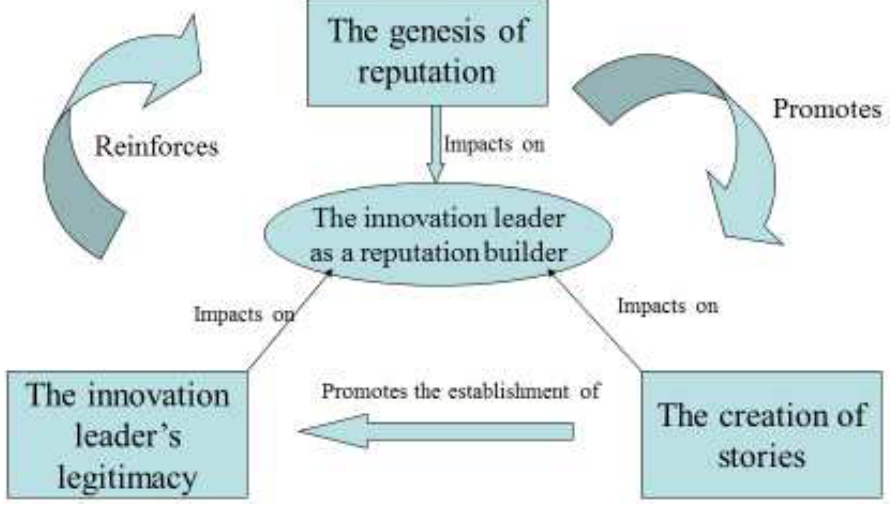
Fig. 3. The innovation leader as a relationship